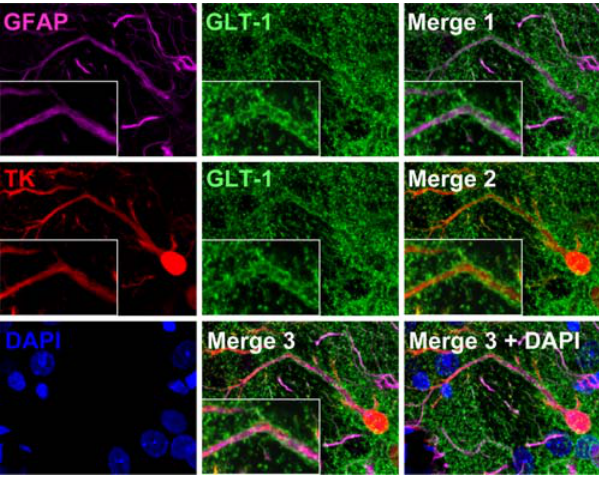
Figure 6. The glutamate transporter GLT-1 is expressed in virally infected astrocytes. Representative confocal images of brain sections stained with markers specific for activated astrocytes (GFAP, magenta), glutamate transporter (GLT-1, green), viral infection (TK, red), and nuclei (DAPI, blue). Merge 1 displays GFAP and GLT-1 immunore- activity to show expression of GLT-1 in astrocytes; Merge 2 shows TK and GLT-1 immunoreactivity to indicate GLT-1 expression in virally infected cells; and Merge 3 depicts GFAP, GLT-1, and TK immunoreac- tivity to demonstrate expression of GLT-1 in virally infected astrocytes. White rectangles show a higher magnification of a triple-labeled process. Note that GLT-1 is expressed in astrocytes, and appears localized to the membrane surrounding GFAP